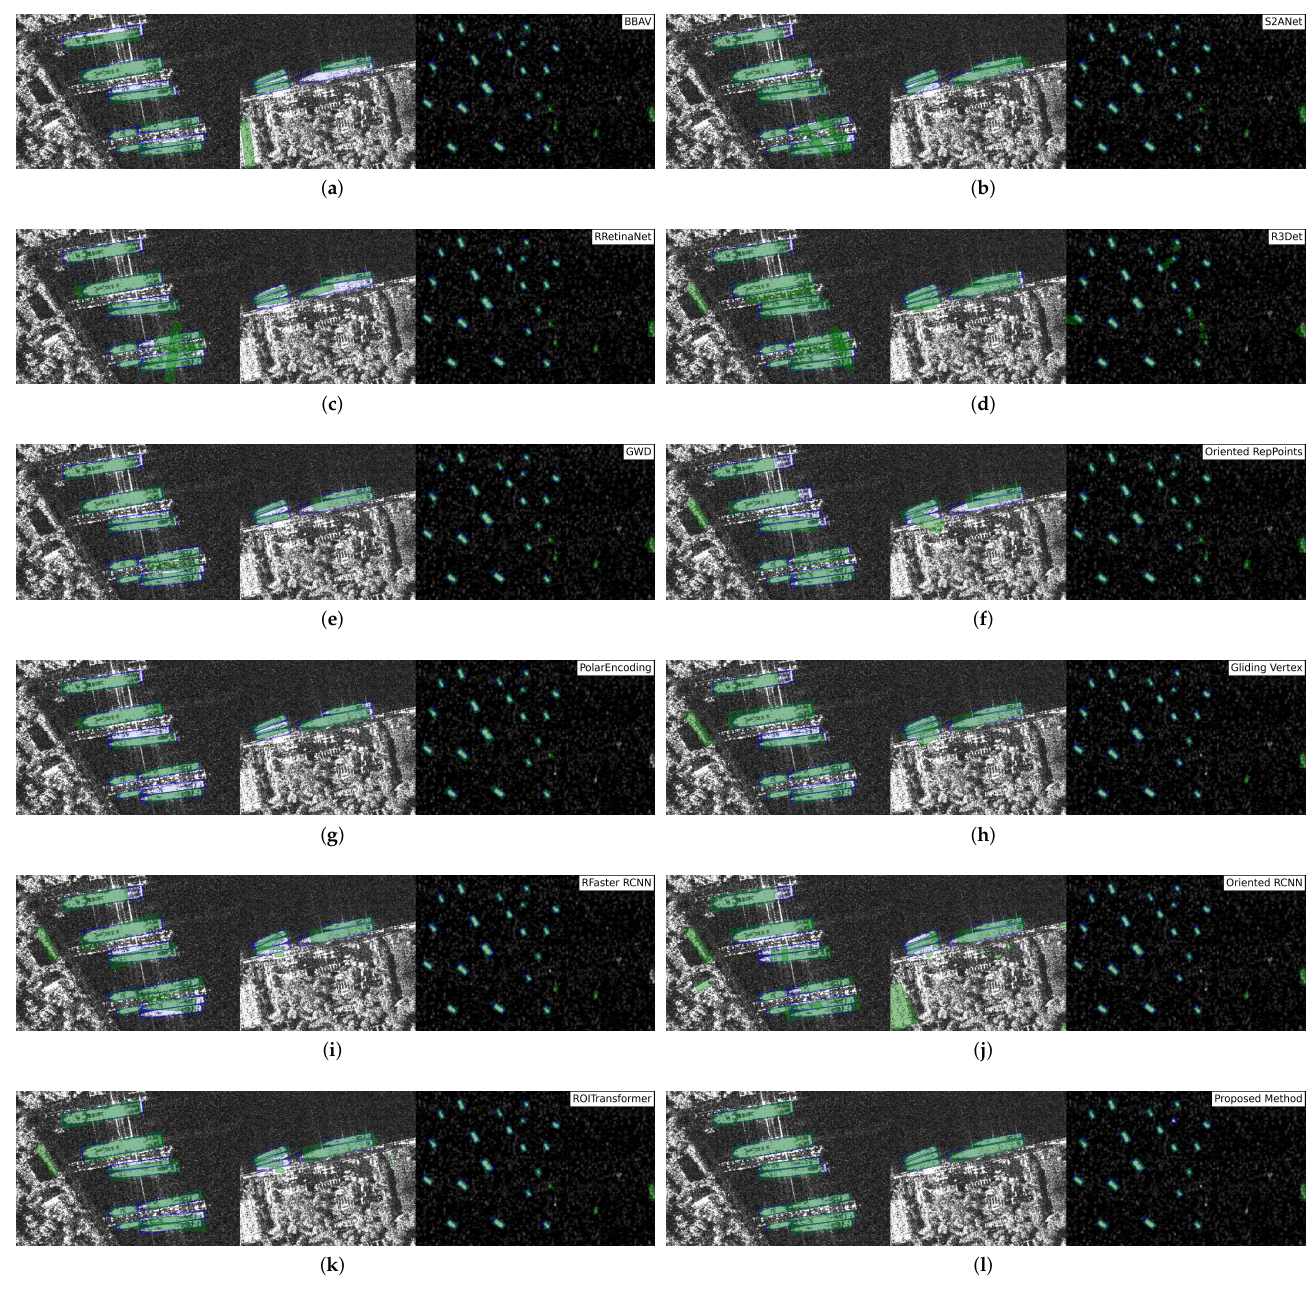
Figure 12. Qualitative detection results on SSDD [2]. The blue and green rectangles are the ground truth and the detected boxes, respectively. This figure is best zoomed in for details. ( a ) BBAV, ( b ) S2ANet, ( c ) RRetinaNet, ( d ) R3Det, ( e ) GWD, ( f ) Oriented RepPoints, ( g ) Polar Encoding, ( h ) Gliding Vertex, ( i ) RFaster RCNN, ( j ) Oriented RCNN, ( k ) ROITransformer, ( l ) proposed